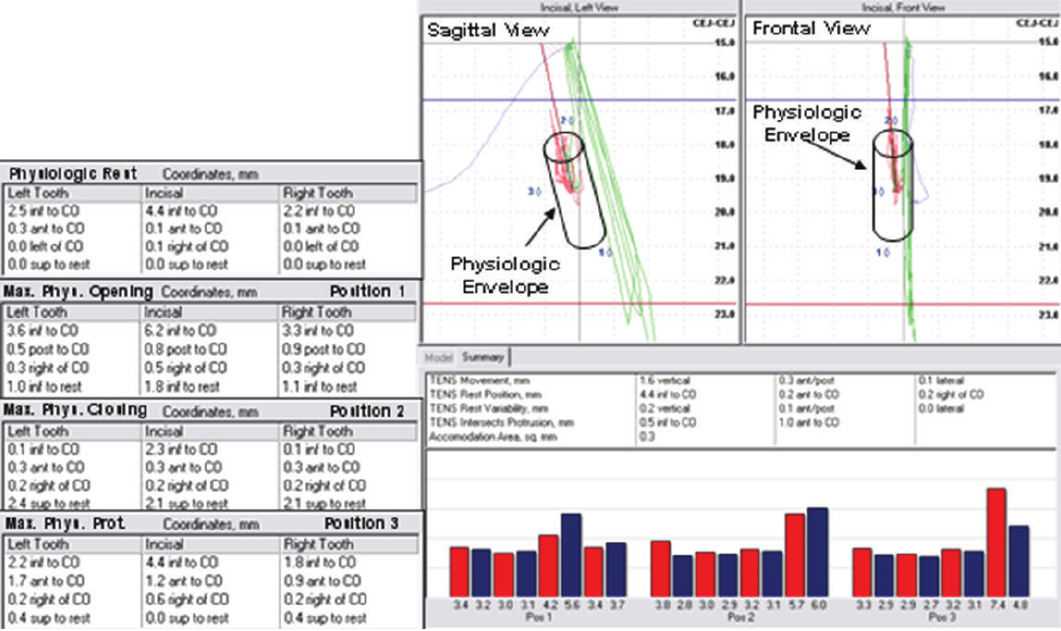
Figure 10: Spatial position of the lower jaw combined with bilateral activity of the temporalis anterior (TA), masseter (MAS), suprahyoid (DIG), and lateral pterygoid (LPT) sites. Coordinates listed are representative of mandibular position relative to centric occlusion and physiologic rest, maximal physiologic opening (position 1), maximal physiologic closing (position 2), and maximal physiologic protrusion (position